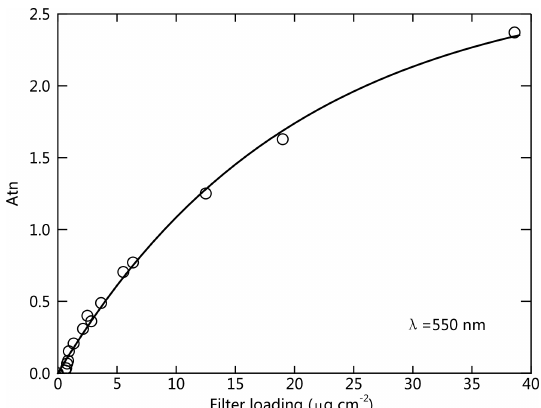
Figure 3. Calibration curve for standard fullerene soot at a wave- length of 550nm. The solid line is a best-fit curve for the filter mea- surements. S 0 and S are the detected signals for the blank and sam- ple filters, respectively, and − ln ( S/S 0 ) is the relative attenuation.